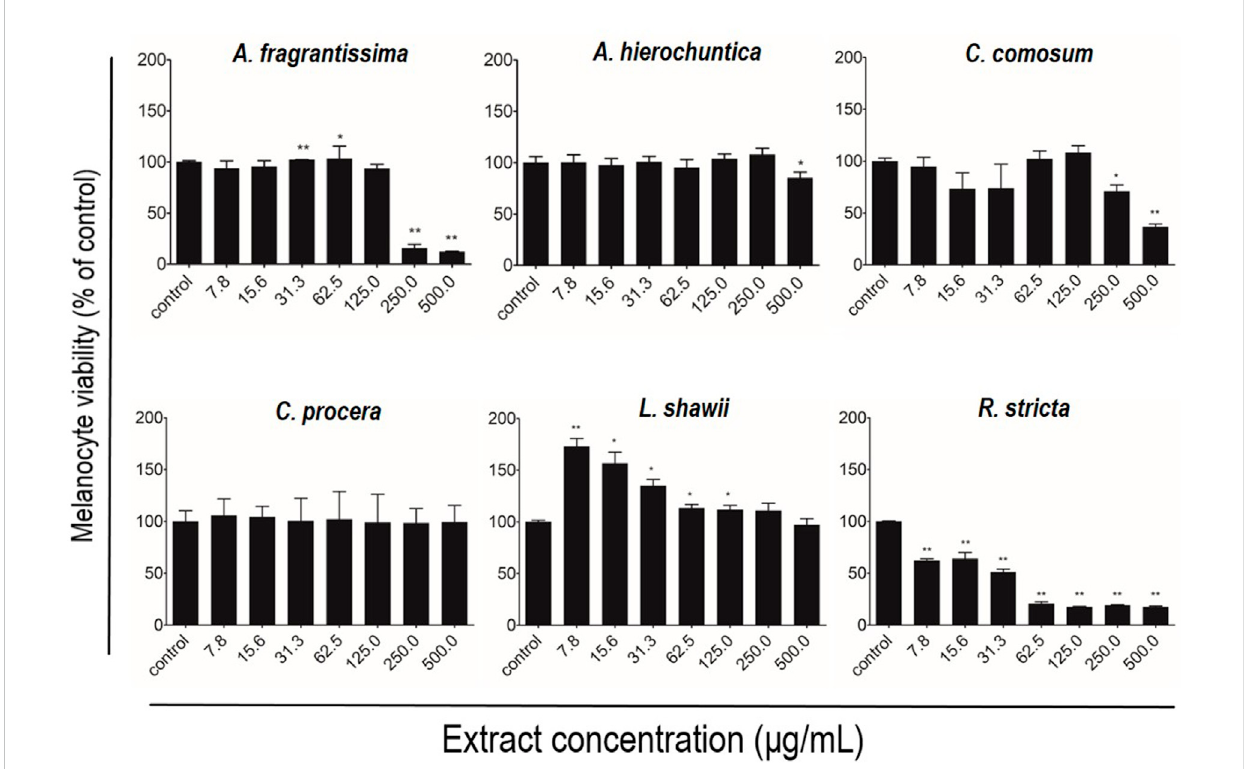
FIGURE 2 Modulatory effects of screened plant extracts on the proliferation of primary human melanocytes using MTT assay. Melanocytes were treated with various concentrations 7.8 – 500 μ g/mL) of different methanolic extracts for 72 h of incubation. Cell viability was assessed using the MTT assay and expressed as a percentage of control, the untreated melanocyte viability, corresponding to 100%. The results are presented as mean ± SD of three independent experiments. * p ≤ 0.05 and ** p ≤ 0.01 signify a statistically signi fi cant difference compared with the